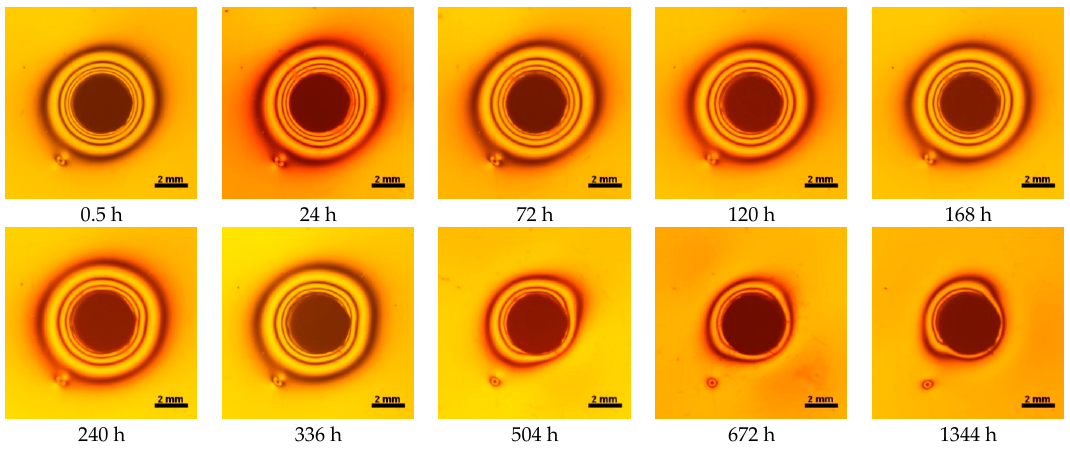
Figure 10. Isochromes in epoxy plate around X-tra base restoration before and after water storage 0.5–1344 h.